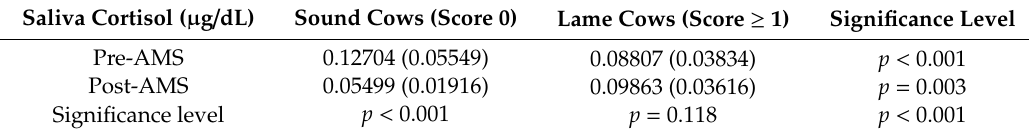
Table 2. Saliva cortisol levels (µg/dL) and standard deviations in sound and lame cows in both pre- and post-AMS conditions.